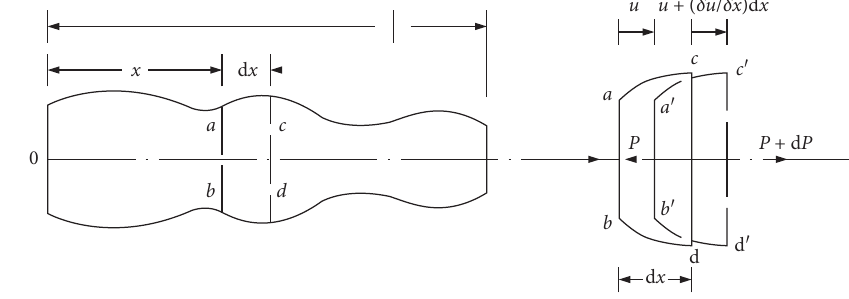
Figure 1: Longitudinal axial vibration of shaft